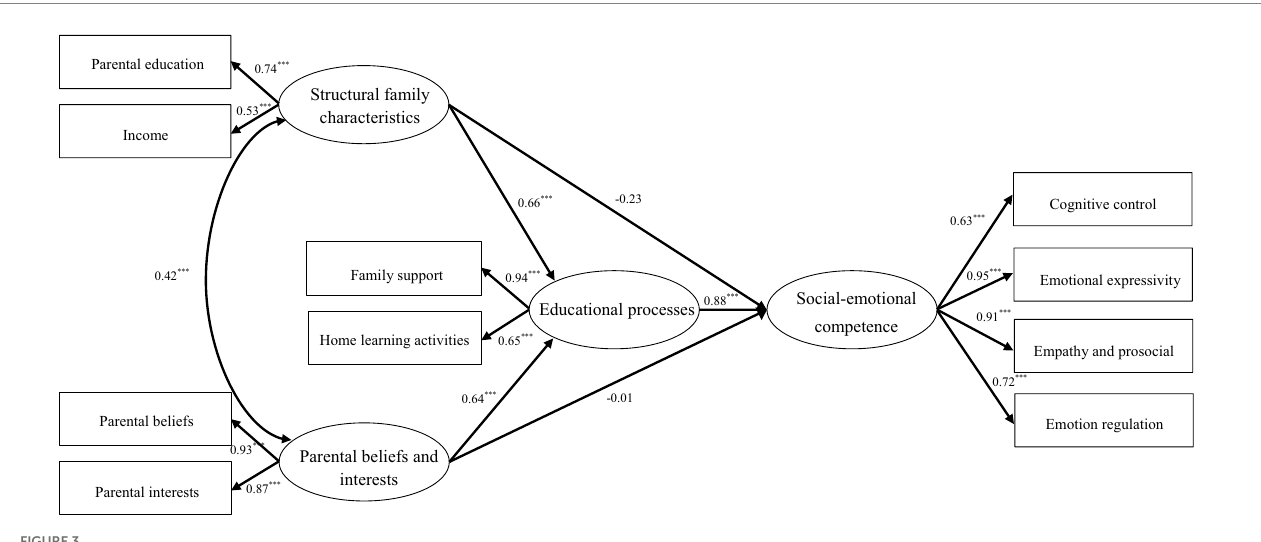
FIGURE 3 The standardized path coefficients describe the mediating role of the educational process between structural family characteristics, parental beliefs and interests and the children’s social–emotional competence. *** p <